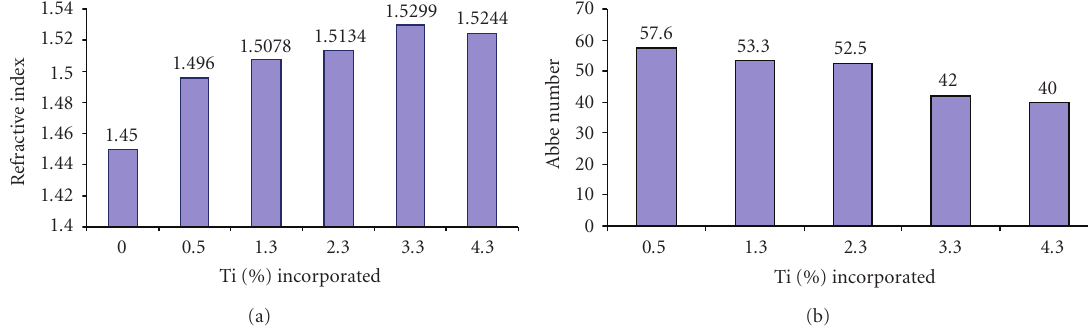
Figure 5: (a) Refractive index increases with increase in titanium content and (b) Abbe number decreases with increase in titanium content.